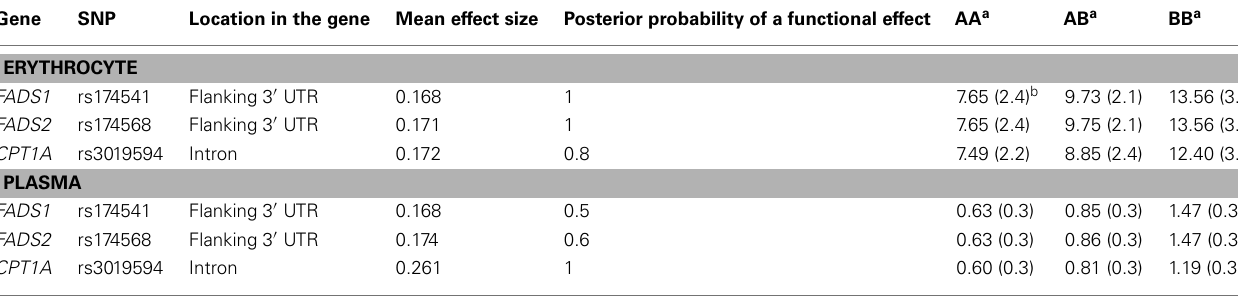
Table 5 | Bayesian quantitative trait nucleotide analysis for erythrocyte and plasma